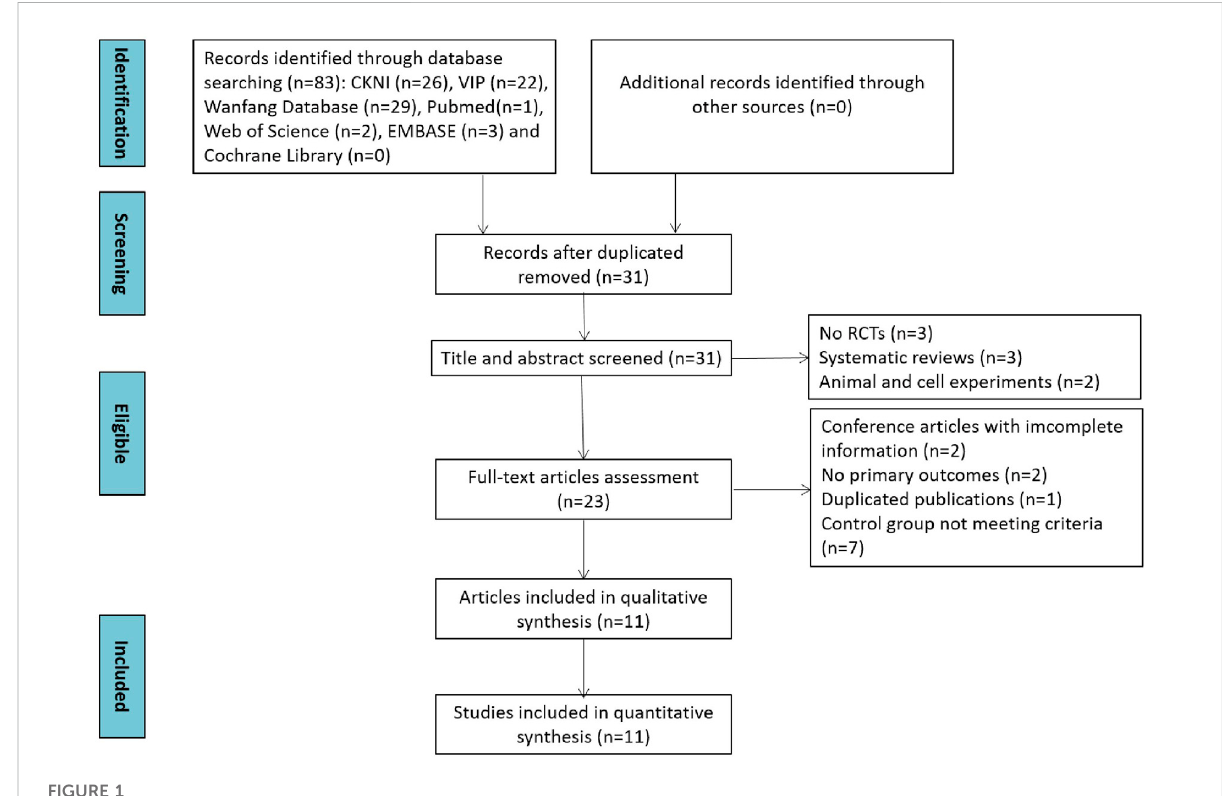
FIGURE 1 Flow diagram of literature